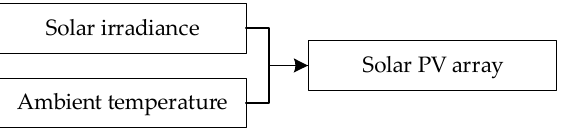
Figure 8. Basic operation model of wind generation.